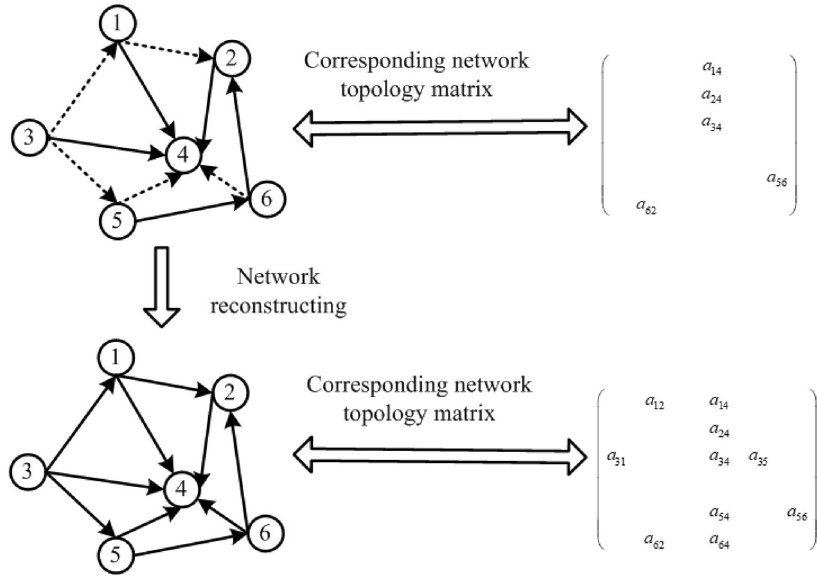
Figure 1. Reconstruction procedure for enterprise debt